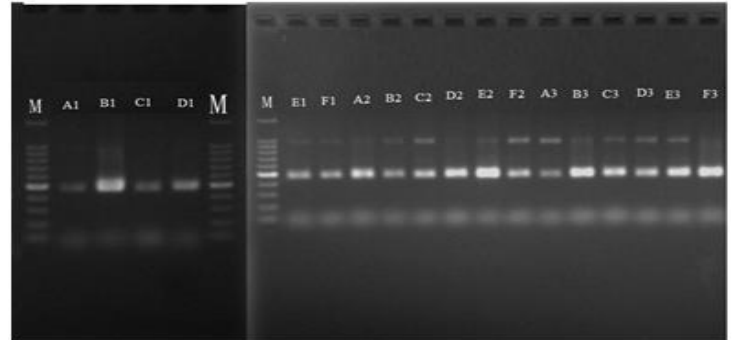
Figure 1. Agarose gel electrophoresis of total DNA in Cinnamomum camphora .